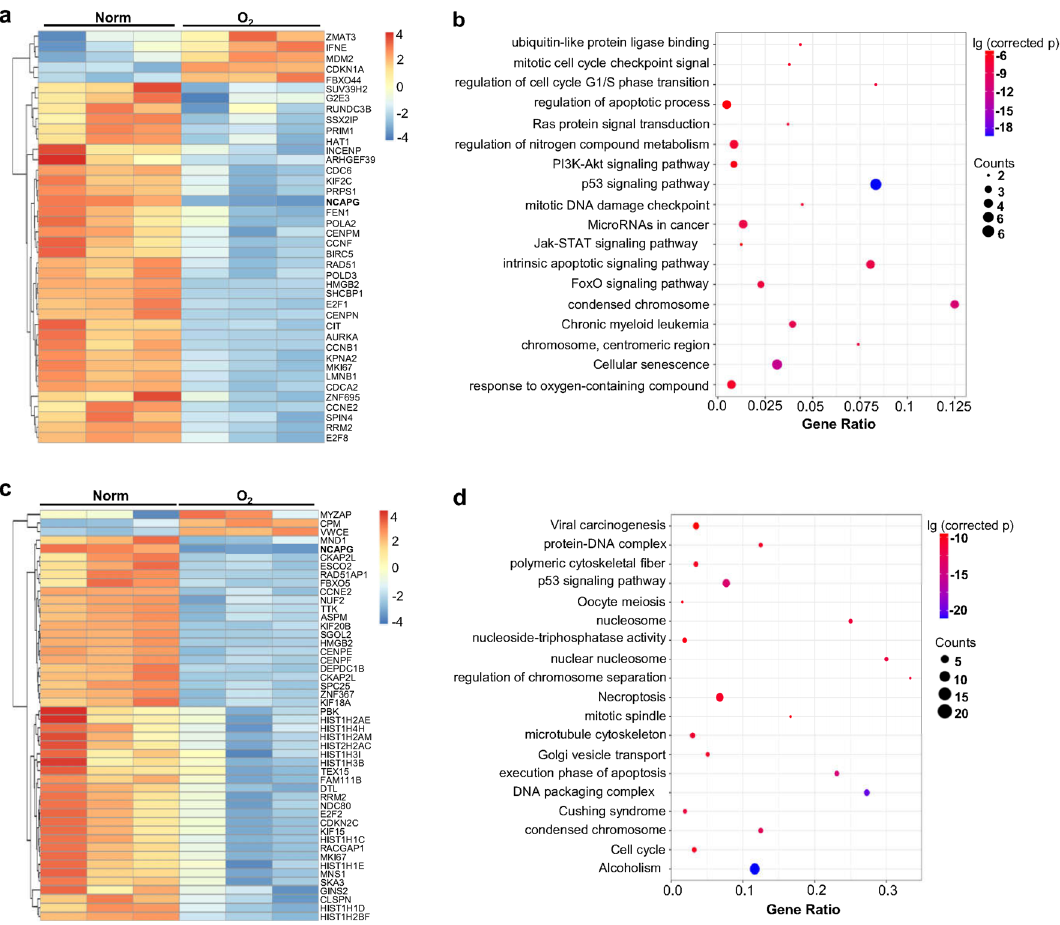
Figure 1. Significantly changed profiles of expression and function induced by hyperoxia in human LMECs. ( a ) Heatmap of the standardized expression levels of the potential target genes of the significantly different miRNAs. These potential target genes were predicated as described in “Material and Methods”. Then, the intersection between these predicated target genes and the significantly differentially expressed mRNAs were selected. Next, the mRNAs in this intersection that were significantly negatively correlated with the levels of miRNA expression (corrected p < 0.05, R < − 0.5) were considered as the potential target genes of the significantly differentially expressed miRNAs. ( b ) Enrichment analysis of the potential target genes of the significantly differentially expressed miRNAs. ( c ) Heatmap of the standardized expression levels of mRNAs that may be regulated by significantly different lncRNAs. The significantly differentially expressed mRNAs that were significantly correlated with the expression levels of lncRNAs (corrected p < 0.05, |R|> 0.5) were thought to be regulated by the corresponding lncRNAs. ( d ) Enrichment analysis of the mRNAs presented in ( c ). Figure ( a–d ) were drawn by R package (R-4.0.0 Version, https:// www.R- proje ct. org) 23